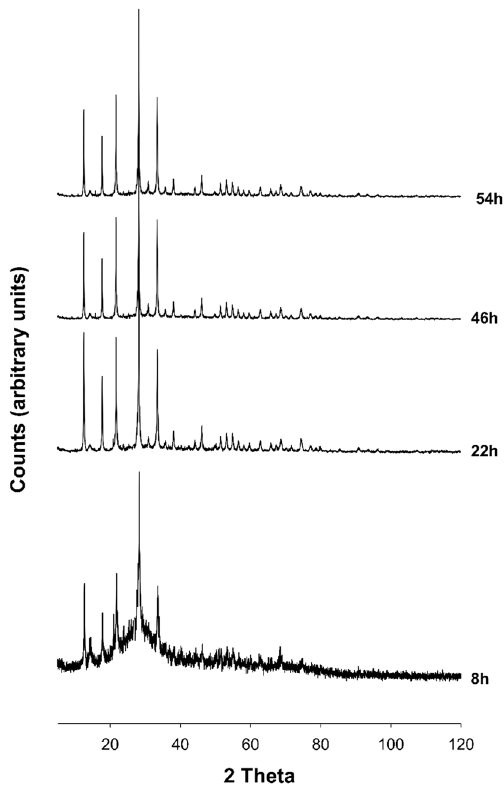
Figure 2. X-ray diffractometric sequence of the synthesis run at 100 °C.